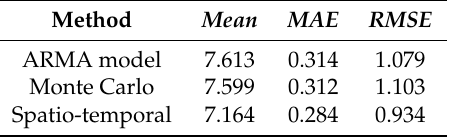
Figure 6. Wind speed scenarios. ( a ) depicts the wind speed scenarios generated by the ARMA method. ( b ) depicts the wind speed scenarios generated by the Spatio-temporal method. ( c ) depicts the wind speed scenarios generated by the Monte Carlo method. Table 2. Forecast error